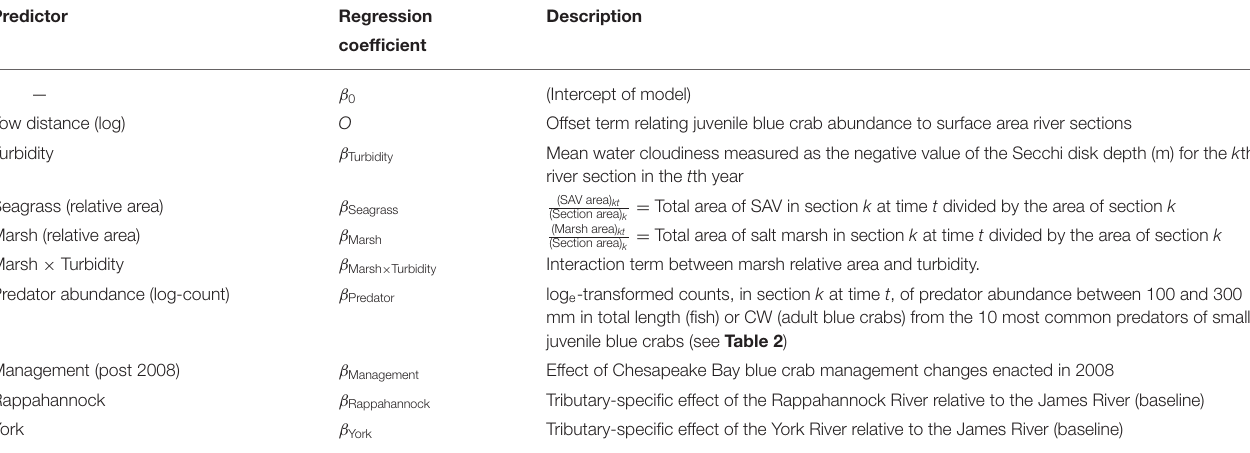
TABLE 1 | Descriptions of predictors used in all initial models.